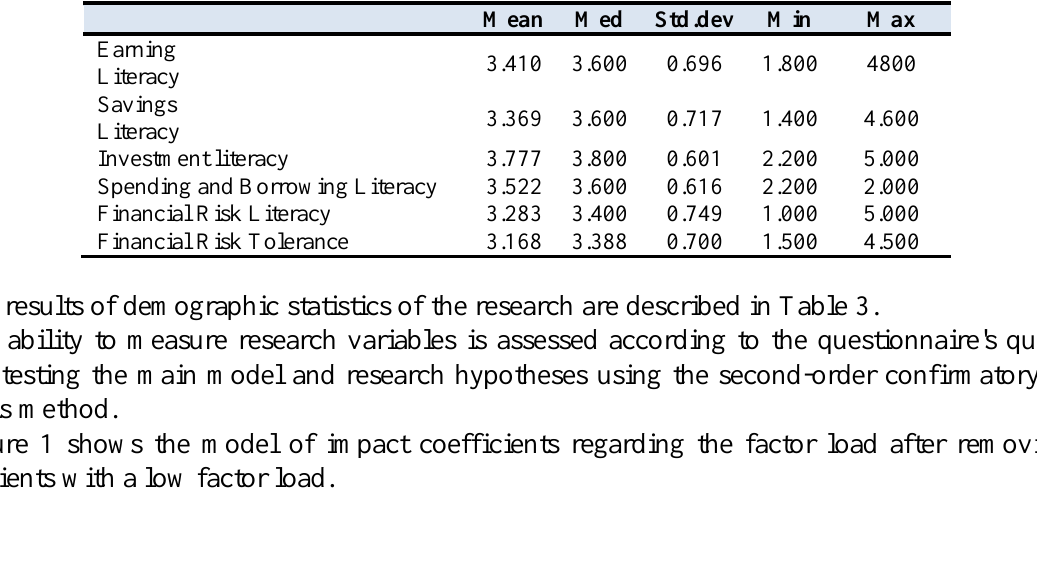
Table 2 . Descriptive